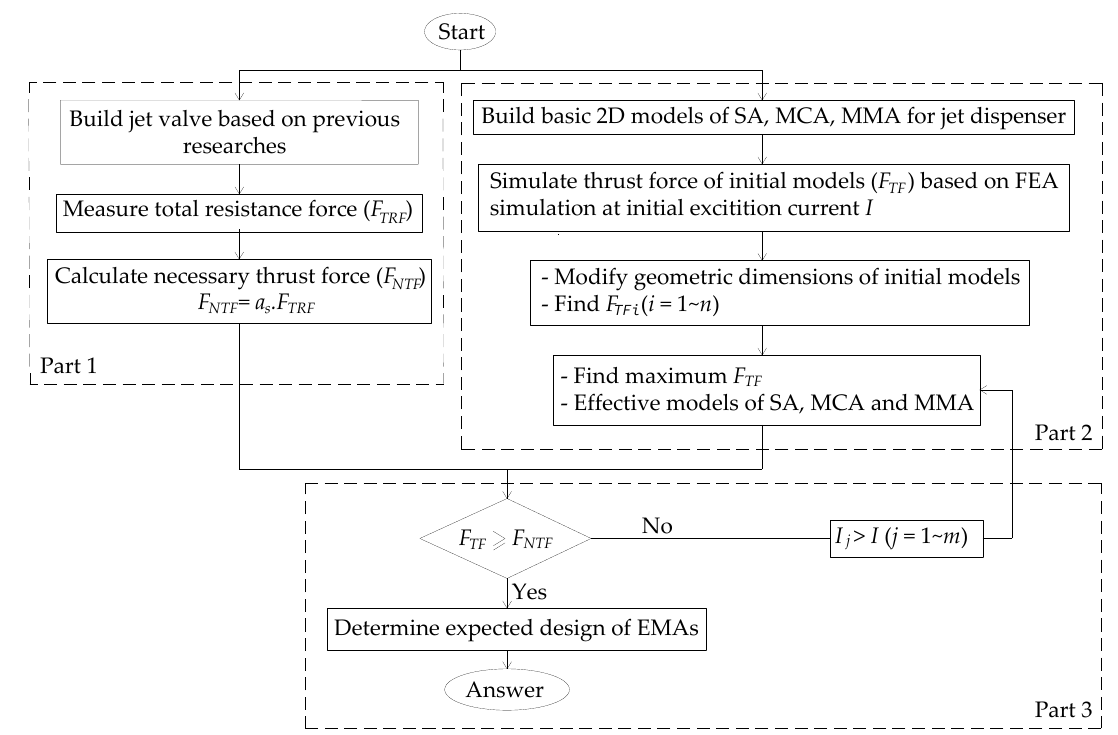
Figure 3. Design and analysis framework for SA, MCA, and MMA mechanisms.